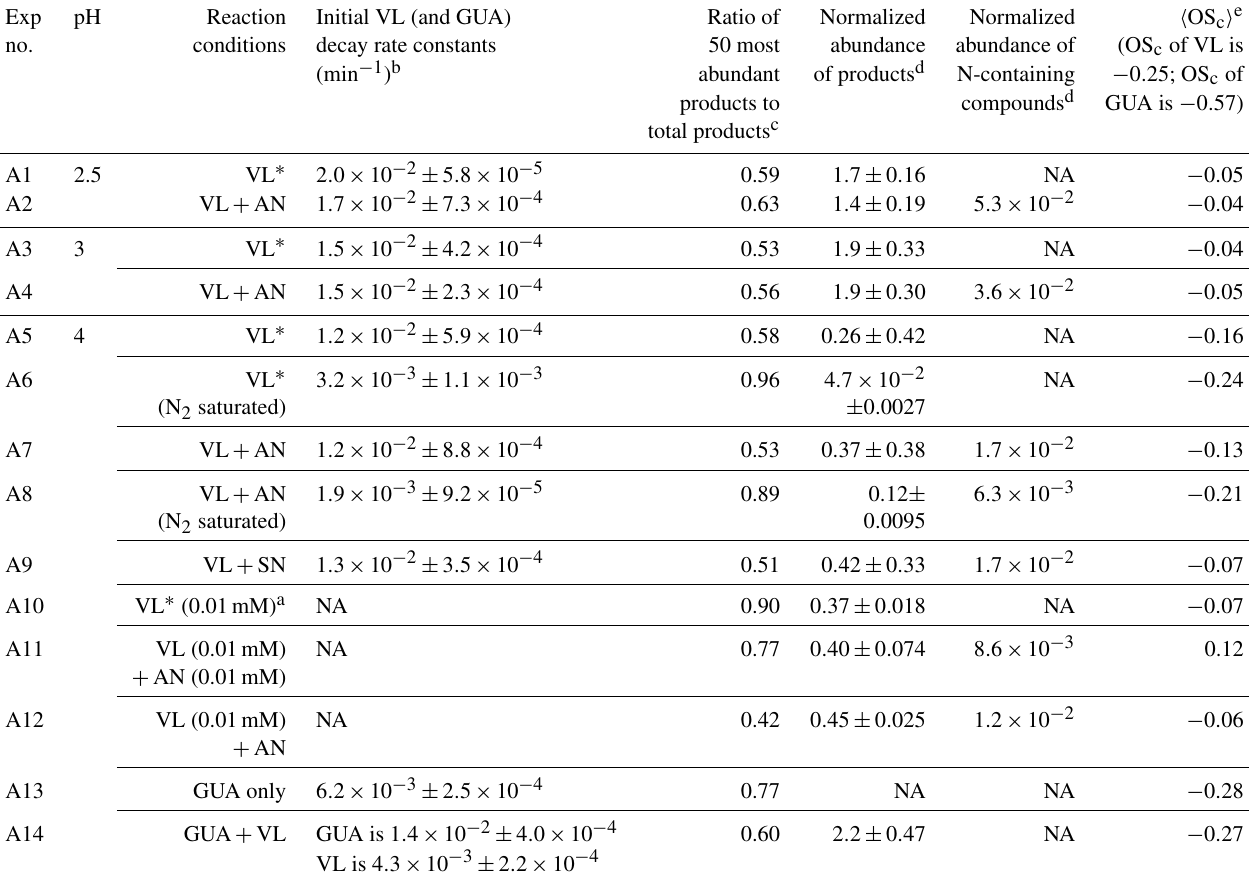
Table 2. Reaction conditions, initial VL (and GUA) decay rate constants, normalized abundance of products, and average carbon oxidation state ( (cid:104) OS c (cid:105) ) in each experiment. Except where noted, the reaction systems consisted of VL (0.1mM), GUA (0.1mM), AN (1mM), and SN (1mM) under air-saturated conditions after 6h of simulated sunlight irradiation. Analyses were performed using UHPLC-qToF-MS equipped with an ESI source and operated in the positive ion